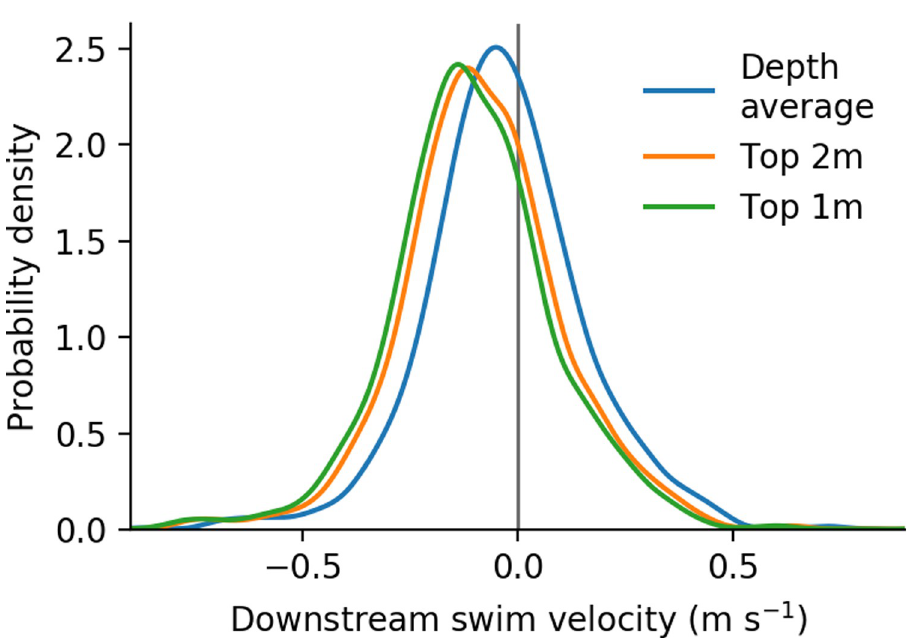
Fig 8. Distributions of longitudinal swimming velocity. Kernel density estimate of longitudinal swimming velocity, normalized to equally weight each individual. Negative values indicate positive rheotaxis (i.e. swimming opposite the